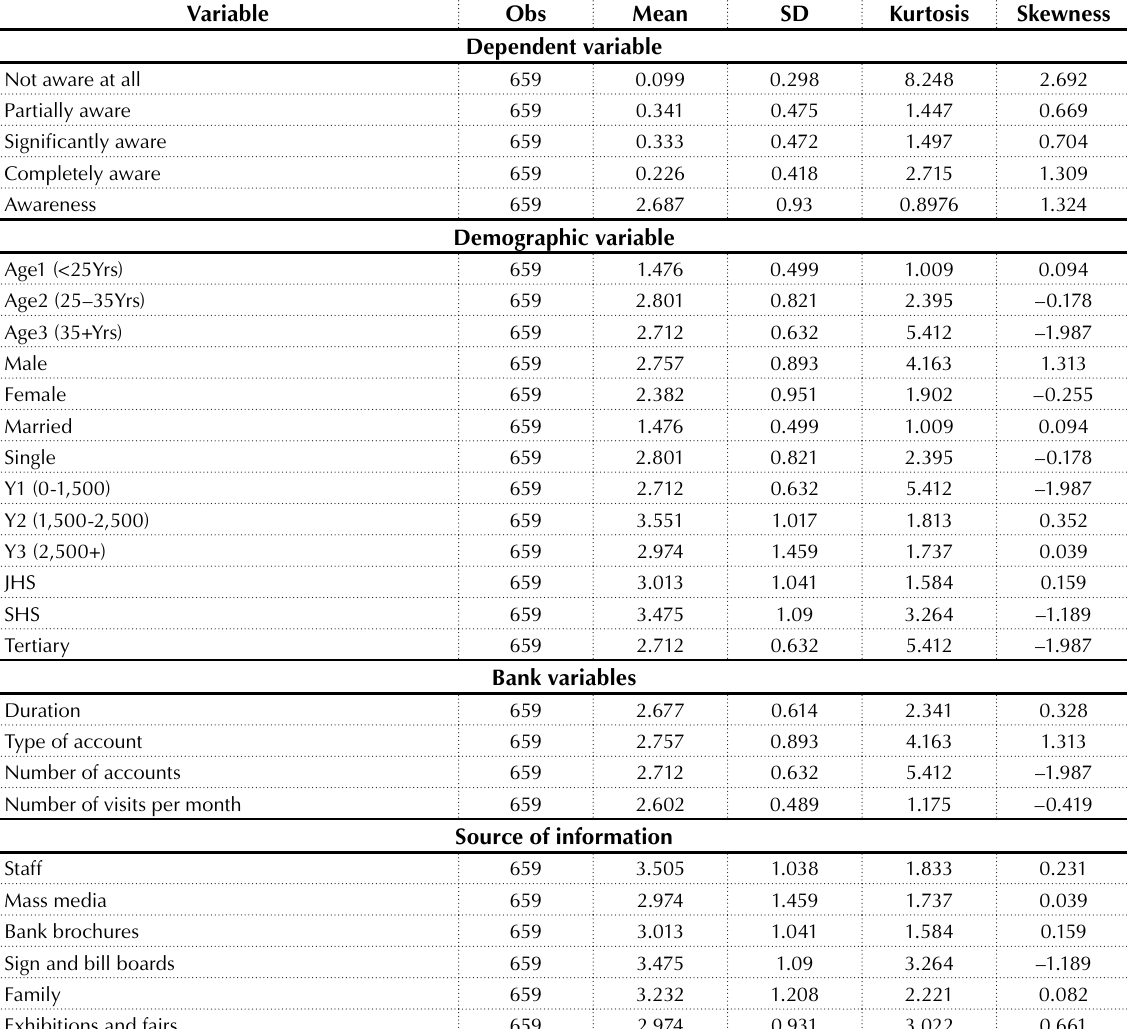
Table 1. Descriptive statistics of variables in the